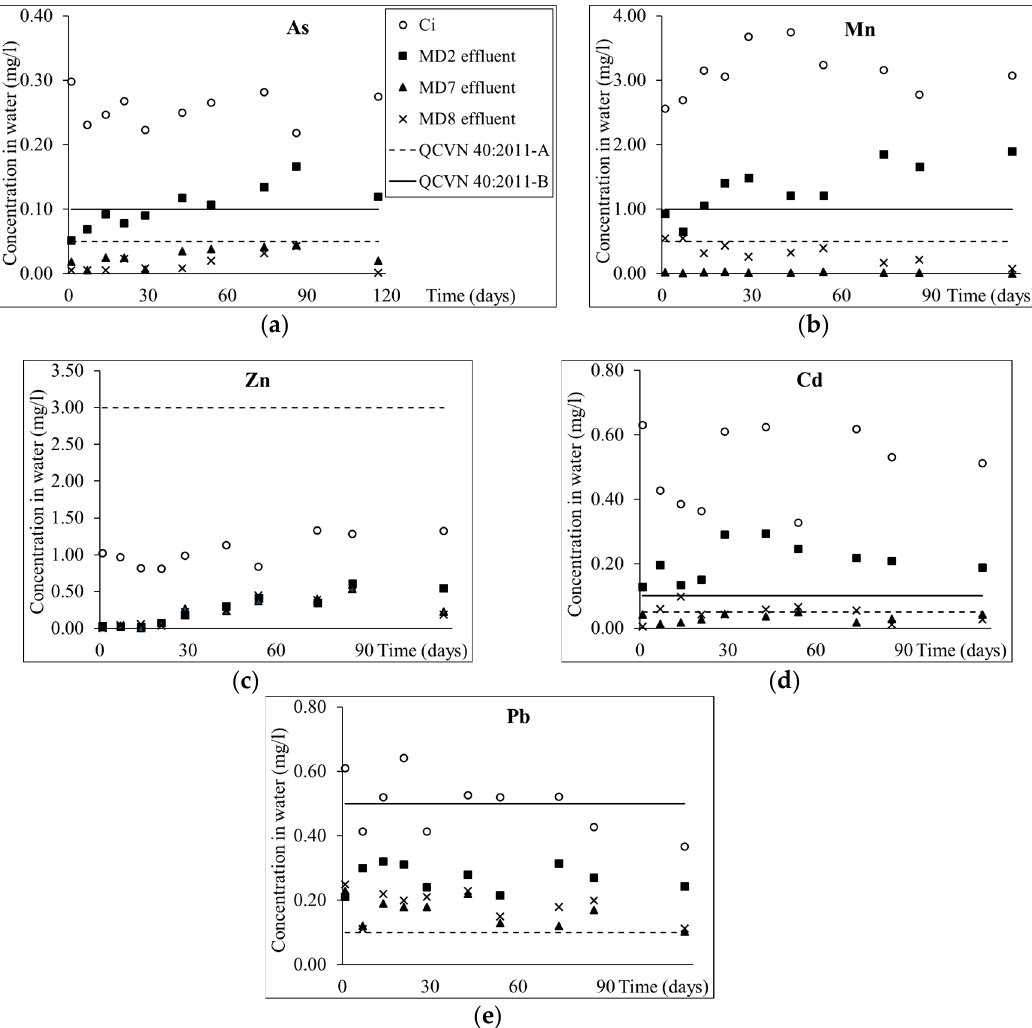
Table 3. Average removal efficiency (%) of As and heavy metals from wastewater in 4 months of operation.